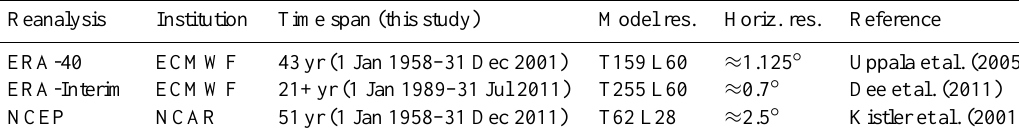
Table 1. Summary of reanalysis data.